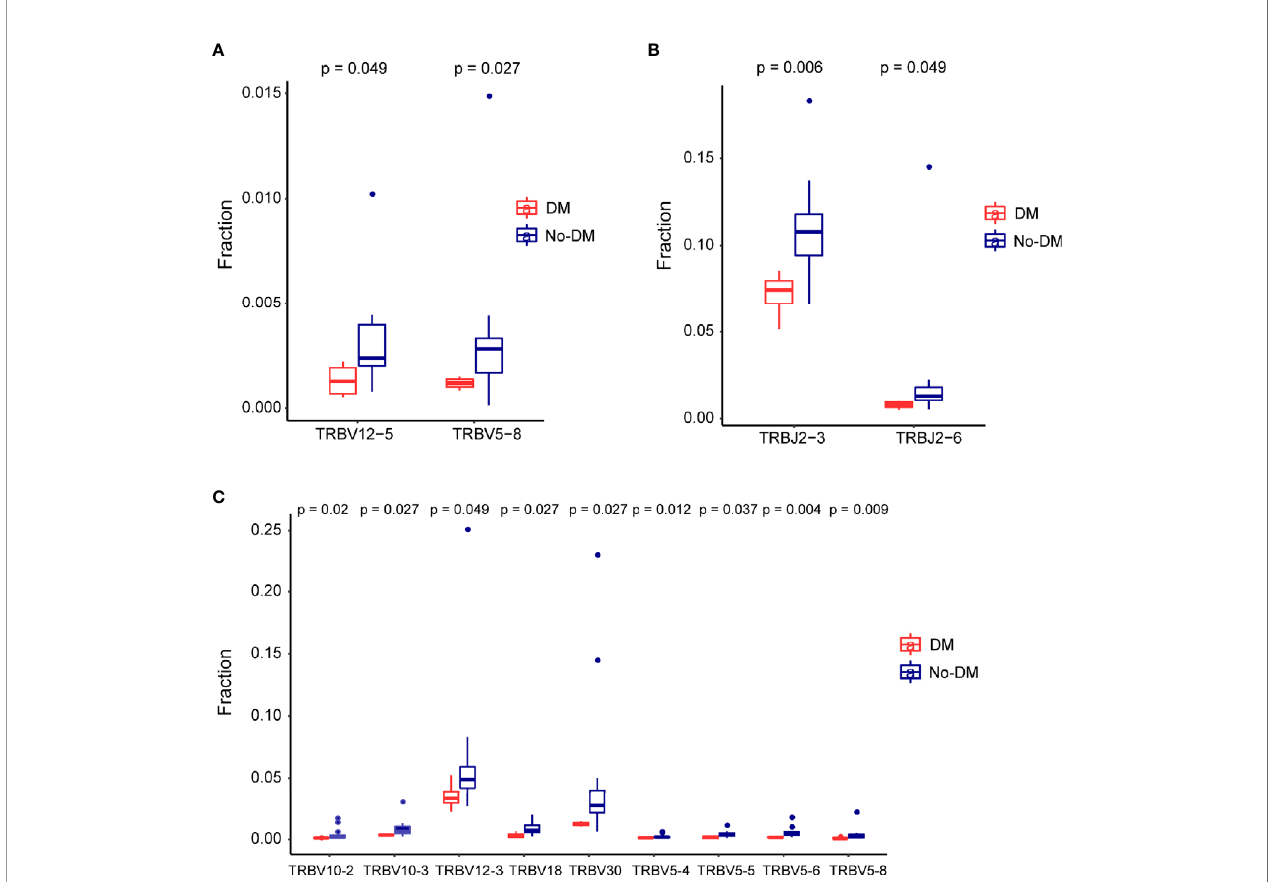
FIGURE 4 | Differences in the T-cell receptor b gene segments in patients with or without failure after SBRT. (A) Two segments from the V gene (TRBV12 − 5 and TRBV5 − 8) were expressed differently in baseline (before-SBRT) peripheral blood samples according to whether patients did (blue, DM) or did not develop metastases after SBRT (red, non-meta). (B, C) Two J segments (B) and 9 V segments (C) were expressed differently in post-SBRT samples according to whether patients did (blue, metastases) or did not develop metastases after SBRT (red,